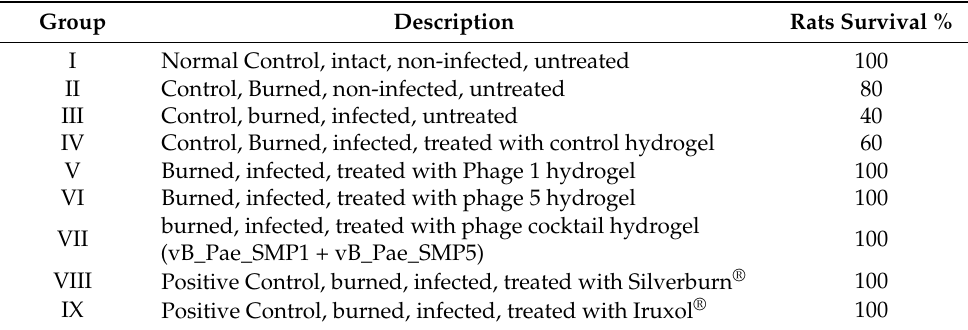
Table 4. Percentage of Survival rate of the examined